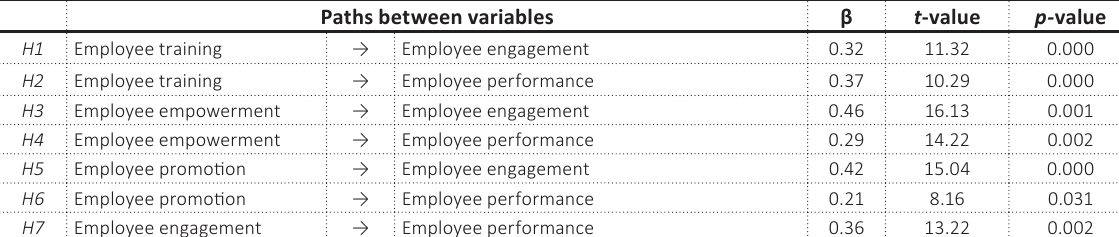
Table 4. Results of hypotheses